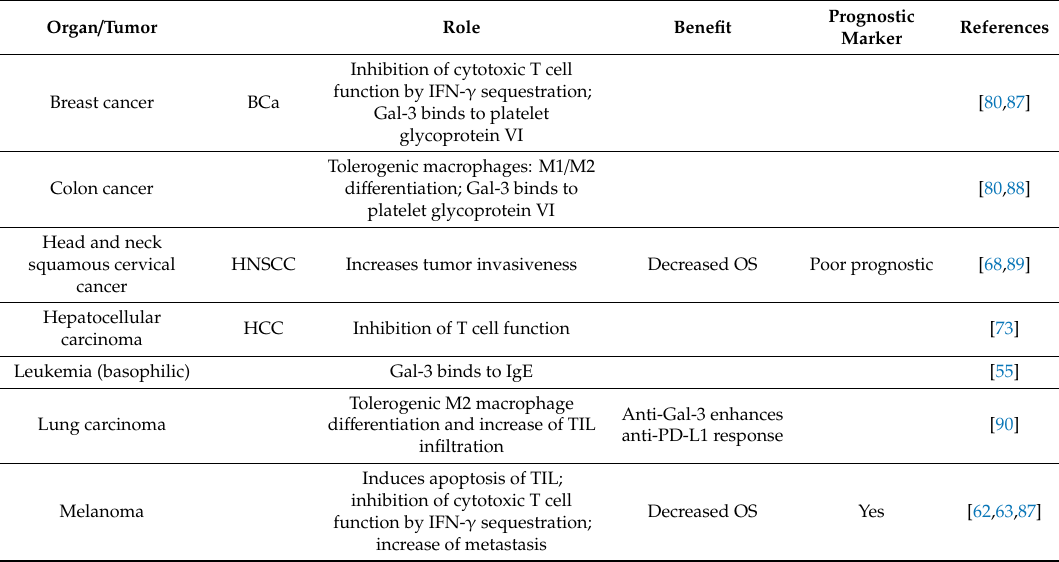
Table 3. Galectin-3 on immune cells in the tumor